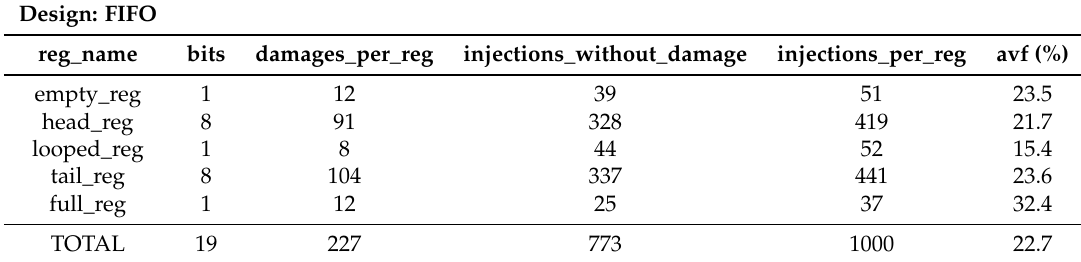
Table 5. Campaign for FIFO (First In First Out)